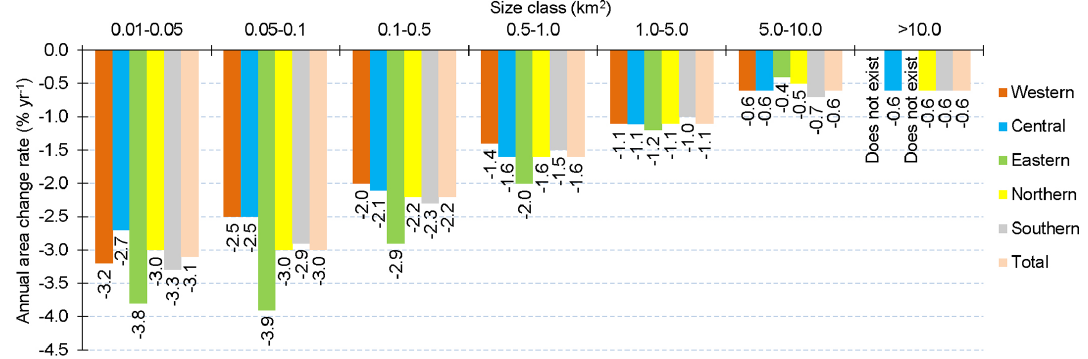
Figure 9. Averaged annual area change rate (%yr − 1 ) from 2000 to 2020 for the seven glacier size classes in all sections and slopes of the Greater Caucasus.